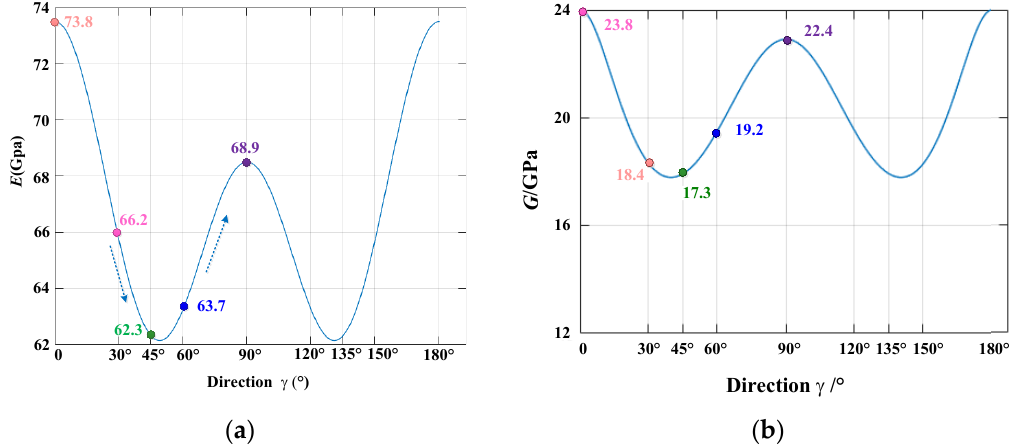
Figure 9. Elastic modulus and shear modulus with the change in γ : ( a ) elastic modulus, ( b ) shear modulus.